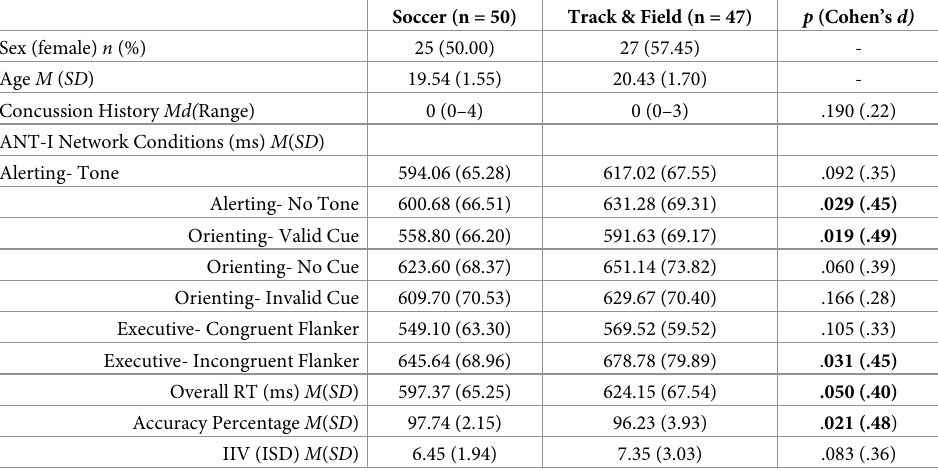
Table 1. Descriptive statistics and ANT-I performance by sport type, N =